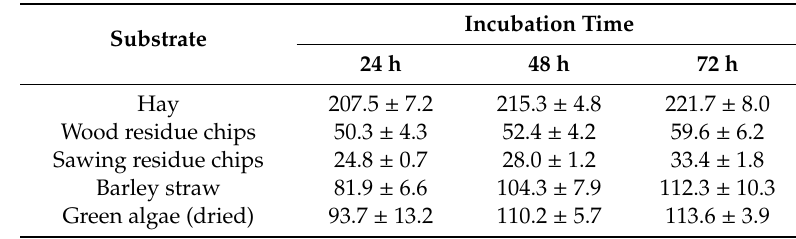
Table 1. Milligrams of fermentable sugar released per g dry biomass with enzyme cocktail obtained from I. lacteus with introduced post-cultivation ultrasound